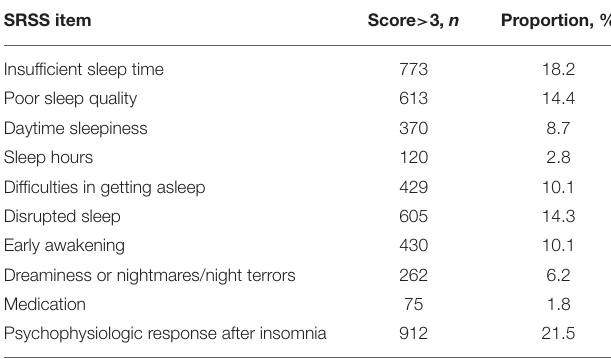
TABLE 3 | The number and percentage (%) of SRSS item score >